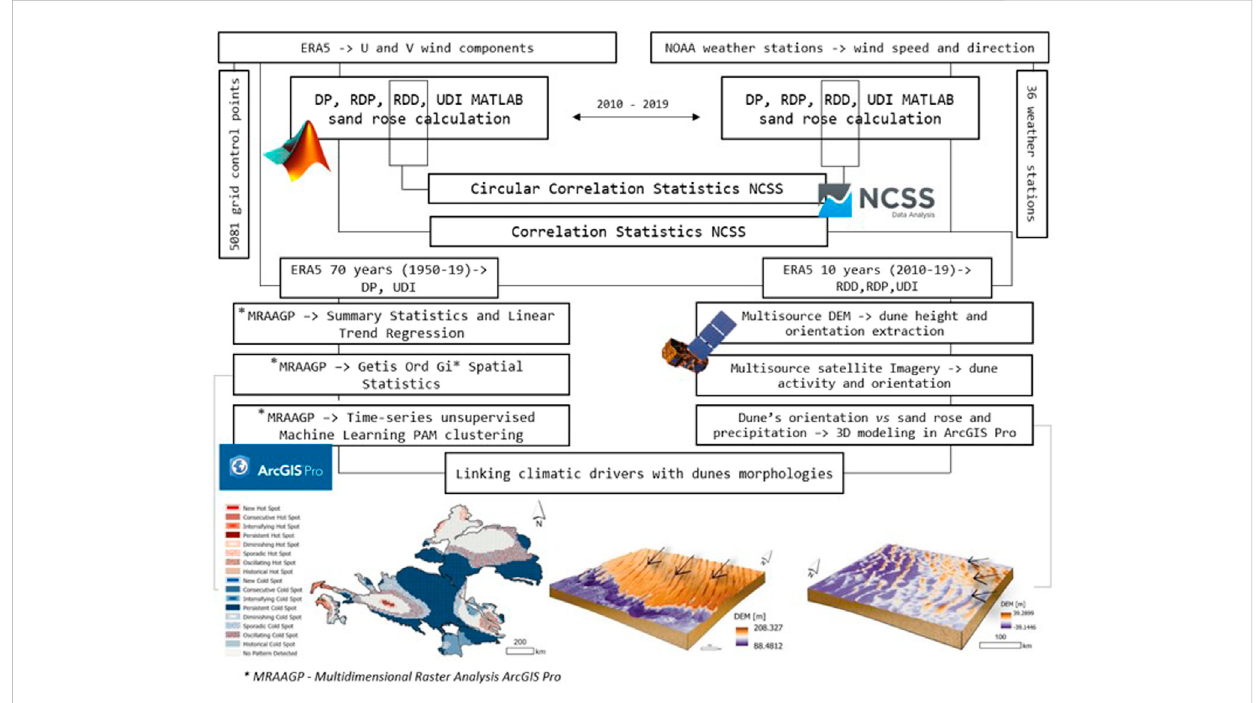
FIGURE 4 Schematic illustration of the methodology applied in this